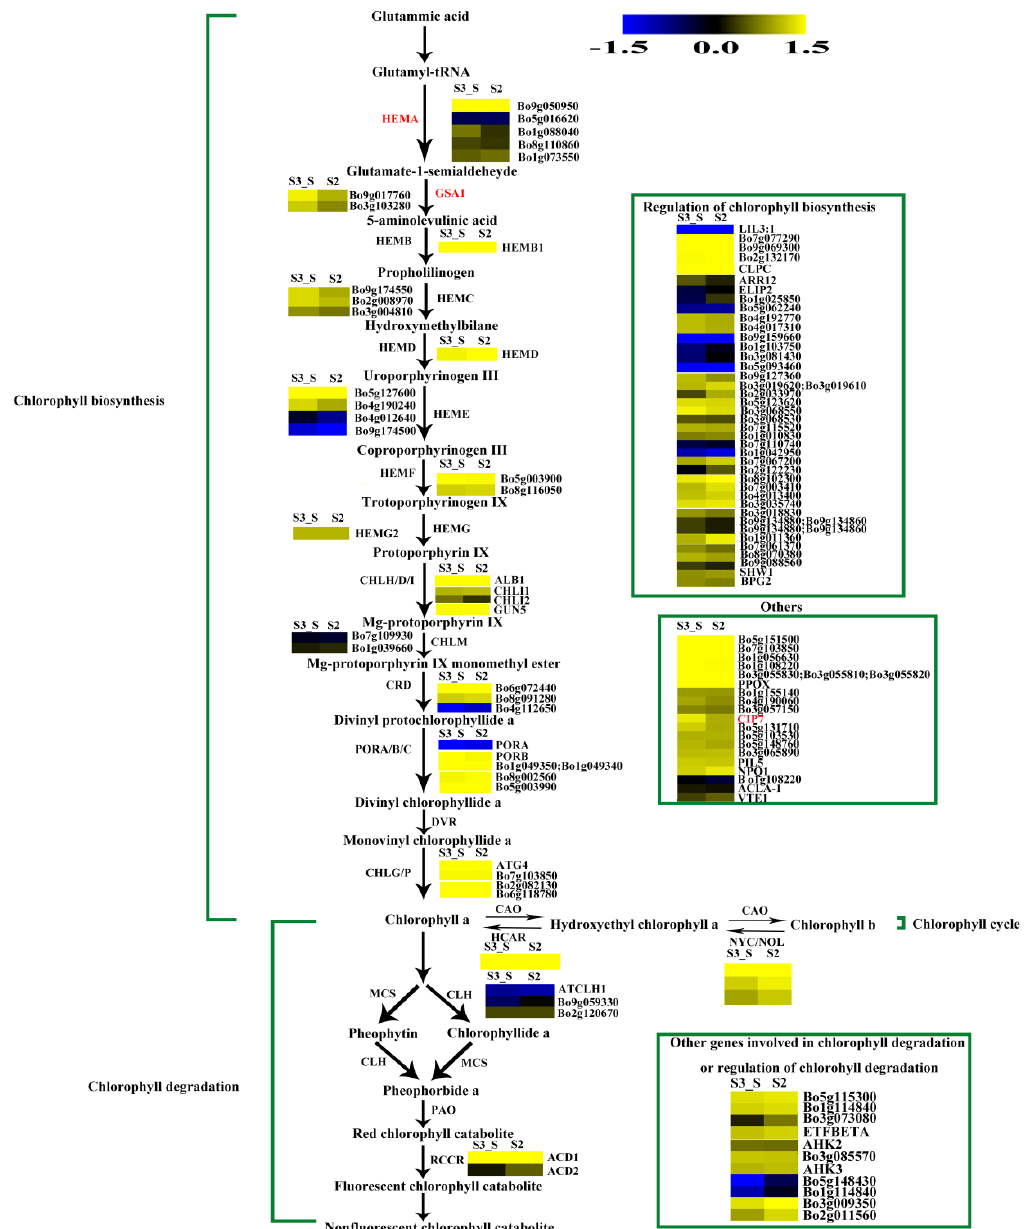
Figure 11. Expression patterns of the genes involved in chlorophyll metabolism in S3_S vs. S2. Enzyme names in red represent upregulated genes in S3_S vs. S2. The green parentheses represent the three steps in chlorophyll metabolism. The genes in the boxes are the other genes involved in chlorophyll metabolism and the genes involved in regulation of chlorophyll metabolism. The black arrows represent the positive regulation.